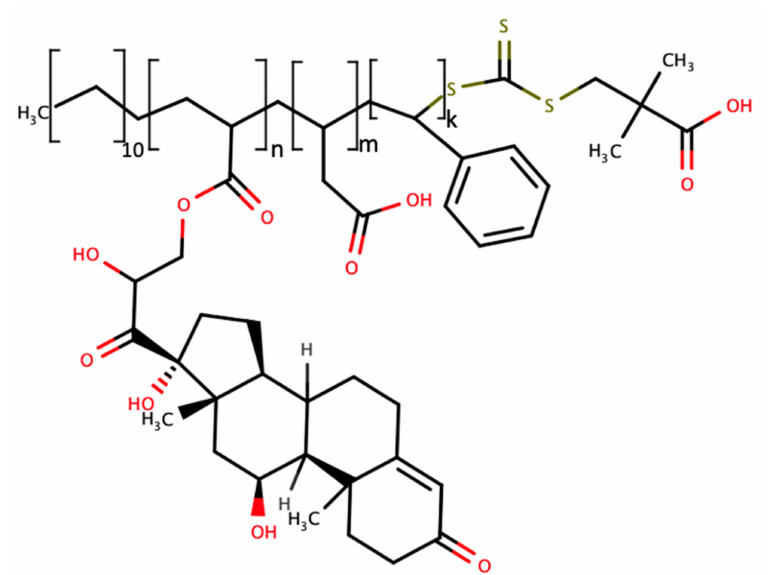
Figure 8. Polymer-bound cortisol hapten (acrylated cortisol) serves as a self-templating element that creates steroid-specific pockets on the surface of the SWCNT bound polymer loops formed by the introduction of hydrophobic copolymers anchoring to the SWCNT surface as well as flexible hydrophilic loops (n, m, k depicts the number of copolymer monomers in each functional segment of the polymer) ([59] Reprinted with permission from Wiley).